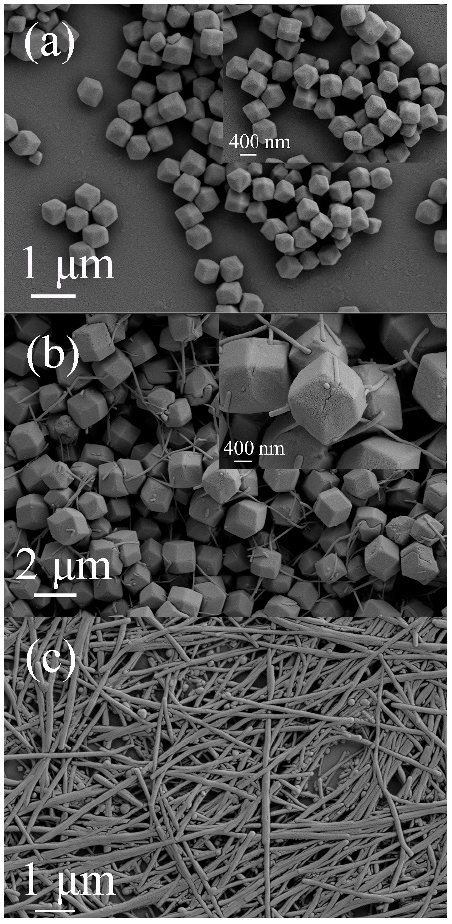
Figure 1. SEM images of ZIF-67 ( a ), ZIF-67/AgNWs ( b ), and AgNWs ( c ). Insets show enlargements of the SEM images for ZIF-67 ( a ) and ZIF-67/AgNWs ( b ).